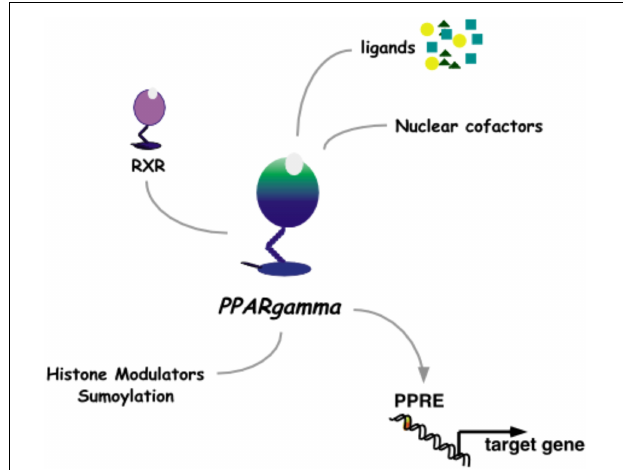
FIGURE 3 | Nuclear receptor PPAR γ . As a heterodimer with RXR γ , PPAR γ mediates transcriptional activation through a PPRE DNA response element in promoters of target genes. This activity is modulated by binding to ligands and nuclear cofactors, as well as fine-tune regulation by sumoylation and histone